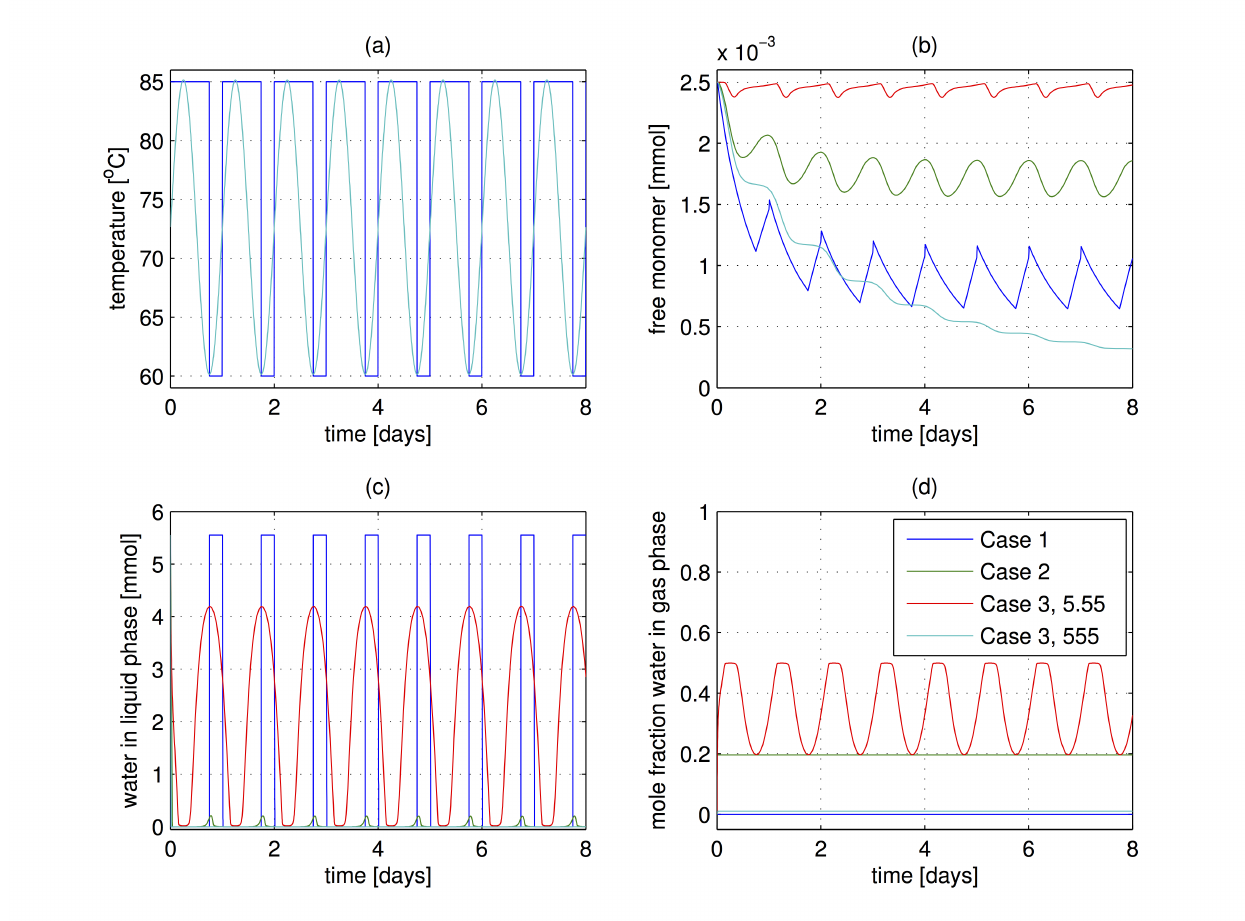
Figure 7. Monomer comsumption versus time for the three scenarios. ( a ) temperature versus time; ( b ) free monomer versus time; ( c ) water in liquid phase versus time; ( d ) water in gas phase versus time. For Case 3, results with small (5.55 µ mol) and large (555 µ mol) headspace are